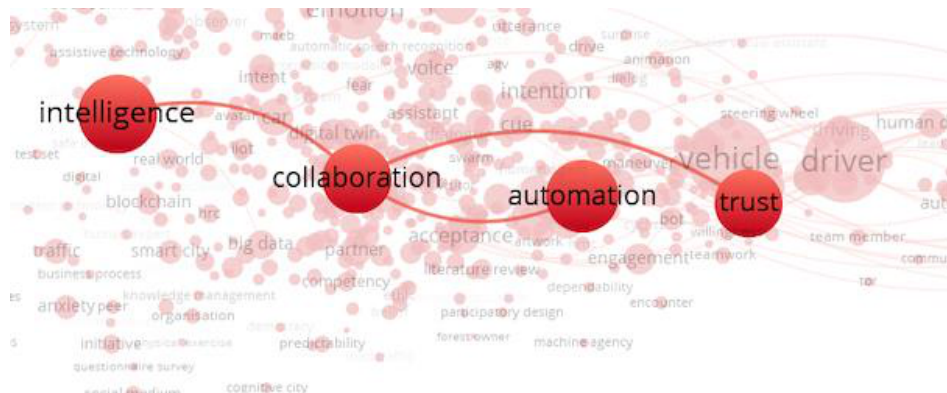
Figure 9. Collaboration dependency.